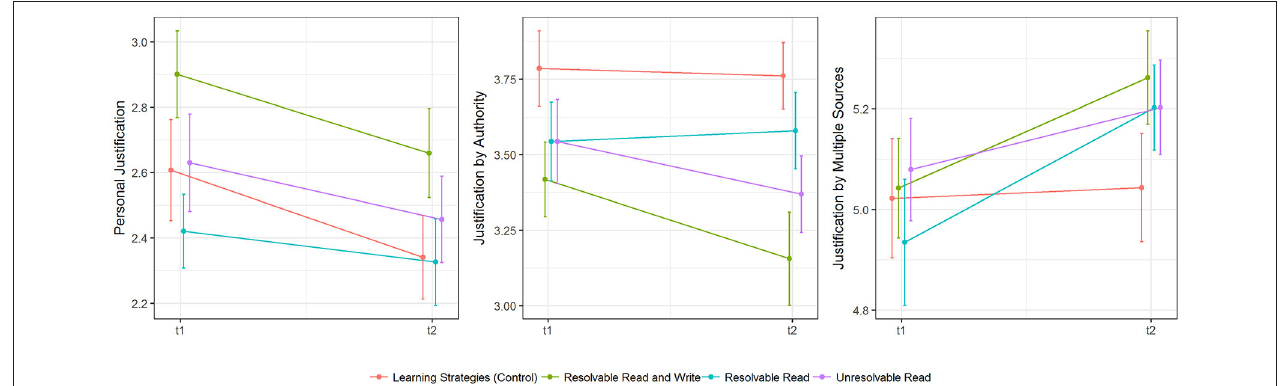
FIGURE 6 | Descriptive differences (means and standard errors) in epistemic change in psychology-specific justification beliefs.